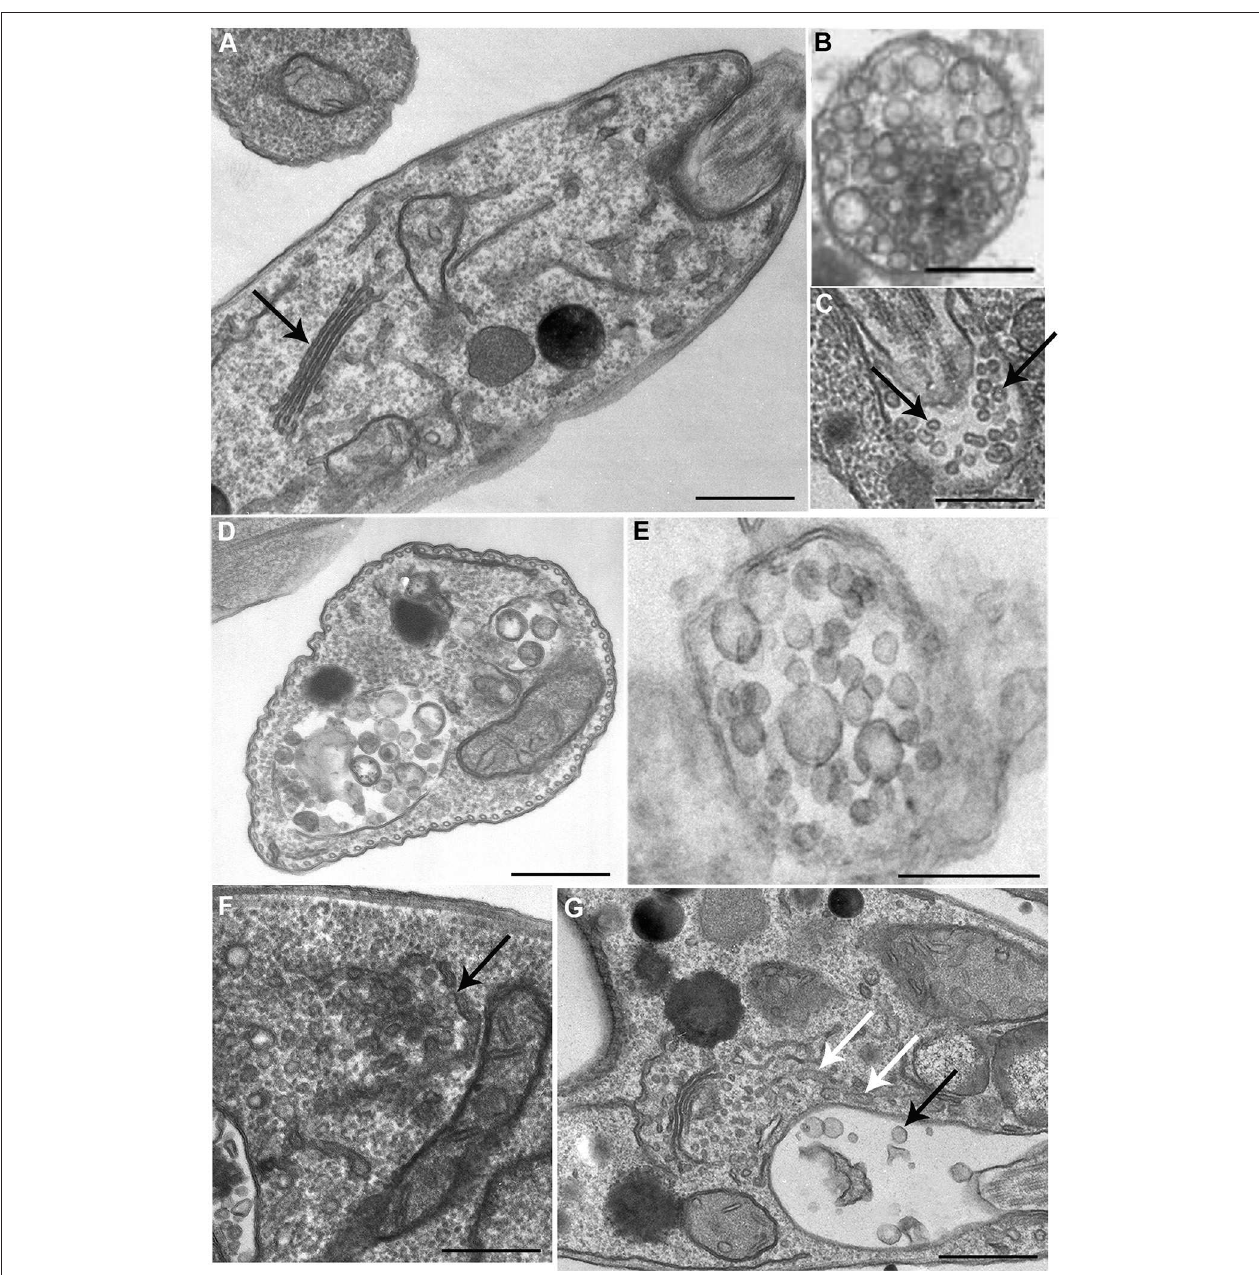
FIGURE 4 | Ultrastructure of endocytic/exocytic pathway organelles in untreated-control and BEL-treated promastigotes. In control cells (A–C) the Golgi complex appears as a compact organelle with aligned stacks ( A , arrow), and cells profiles contain multivesicular bodies (B,D,E) and numerous small vesicles within the flagellar pocket (arrows in C ). Treatment with BEL led to intensive Golgi vesiculation (arrow in F ), some tubules with a branched aspect in the proximity of the flagellar pocket (white arrows in G ) and a significant decrease in the number of small vesicles in the flagellar pocket (black arrow in G ). Representative images of three independent experiments. Bars, 300